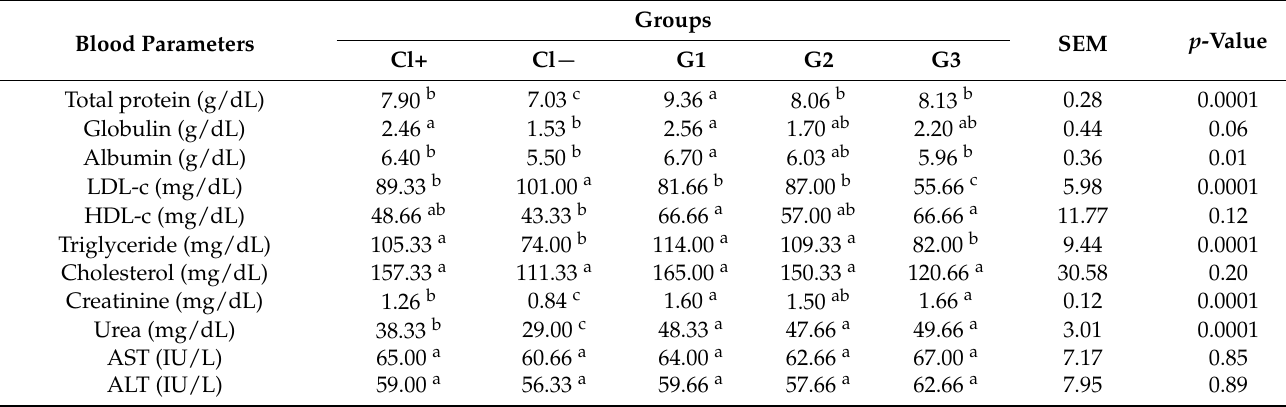
Table 7. Serum biochemical properties of rabbits as affected by yogurt containing 1% whey protein concentrate (G1), calcium caseinate (G2) and Spirulina powder (G3) compared to that of a non-supplemented yogurt as a positive control (Cl+) or a yogurt-free diet as a negative control (Cl −